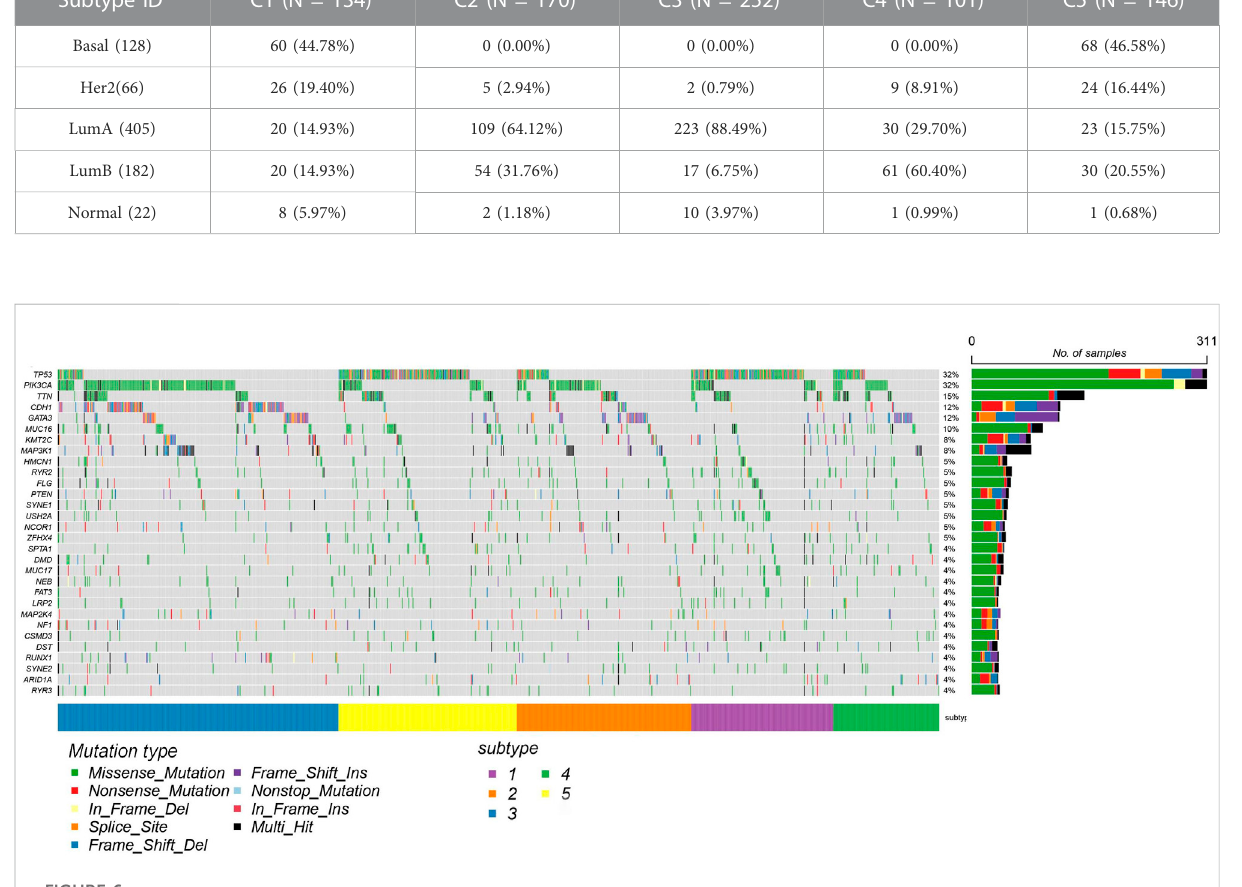
FIGURE 6 The mutation pro fi les of BRCA datasets with 20 signi fi cantly mutated genes using mRNA expression